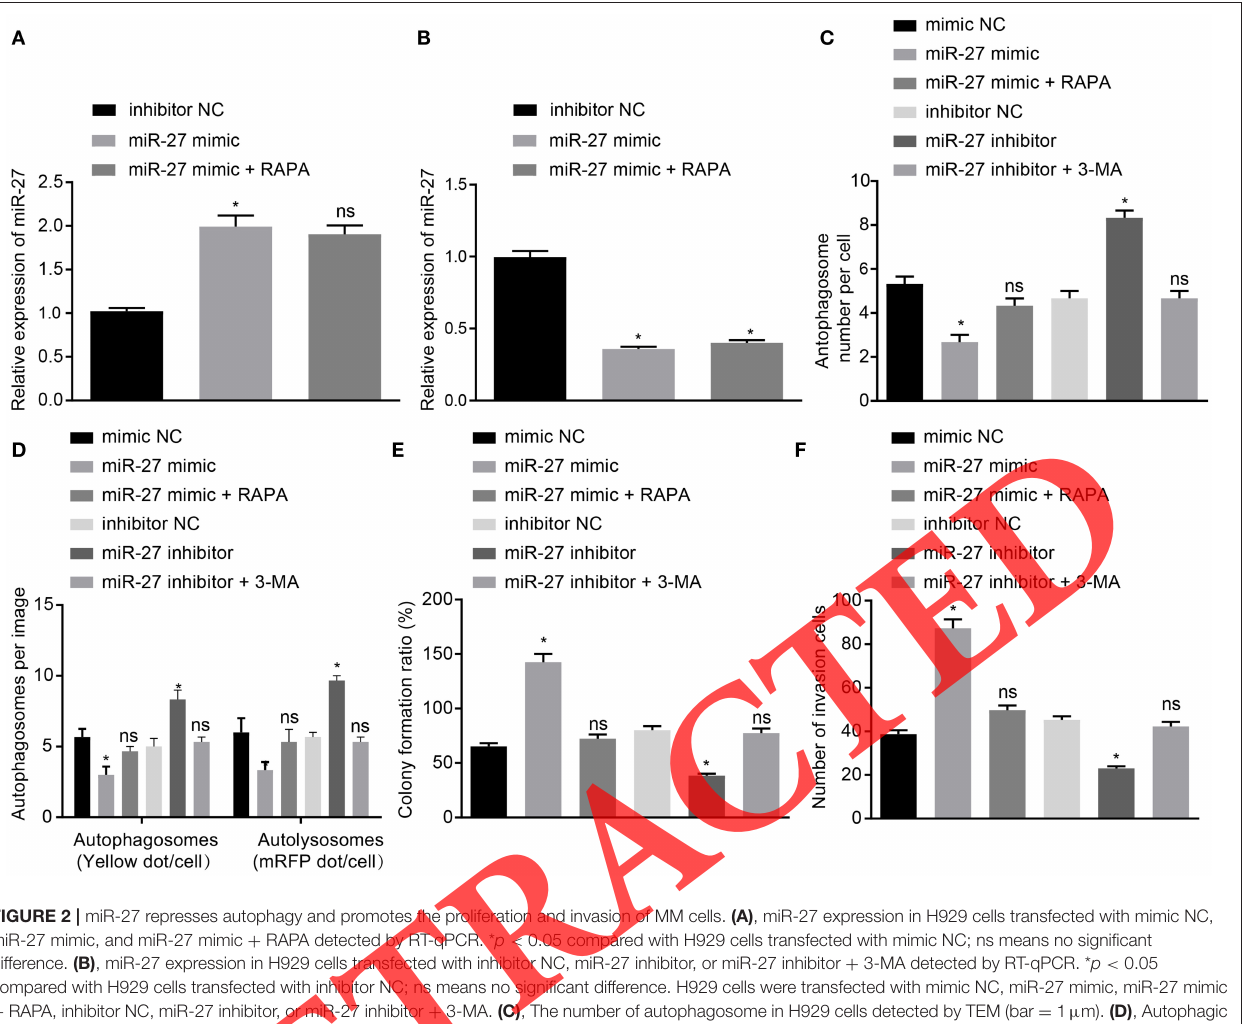
FIGURE 2 | miR-27 represses autophagy and promotes the proliferation and invasion of MM cells. (A) , miR-27 expression in H929 cells transfected with mimic NC, miR-27 mimic, and miR-27 mimic + RAPA detected by RT-qPCR. * p < 0.05 compared with H929 cells transfected with mimic NC; ns means no significant difference. (B) , miR-27 expression in H929 cells transfected with inhibitor NC, miR-27 inhibitor, or miR-27 inhibitor + 3-MA detected by RT-qPCR. * p < 0.05 compared with H929 cells transfected with inhibitor NC; ns means no significant difference. H929 cells were transfected with mimic NC, miR-27 mimic, miR-27 mimic + RAPA, inhibitor NC, miR-27 inhibitor, or miR-27 inhibitor + 3-MA. (C) , The number of autophagosome in H929 cells detected by TEM (bar = 1 µ m). (D) , Autophagic flow in H929 cells (bar = 25 µ m). (E) , Proliferative capacity of H929 cells detected by clone formation assay. (F) , Invasion ability of H929 cells determined by Transwell assay (bar = 50 µ m) * p < 0.05 compared with H929 cells transfected with mimic NC or inhibitor NC. The data were measurement data and expressed as mean ± standard deviation. Unpaired t -test was used for comparison between two groups, and one-way ANOVA was used for comparison among multiple groups. The cell experiment was repeated three